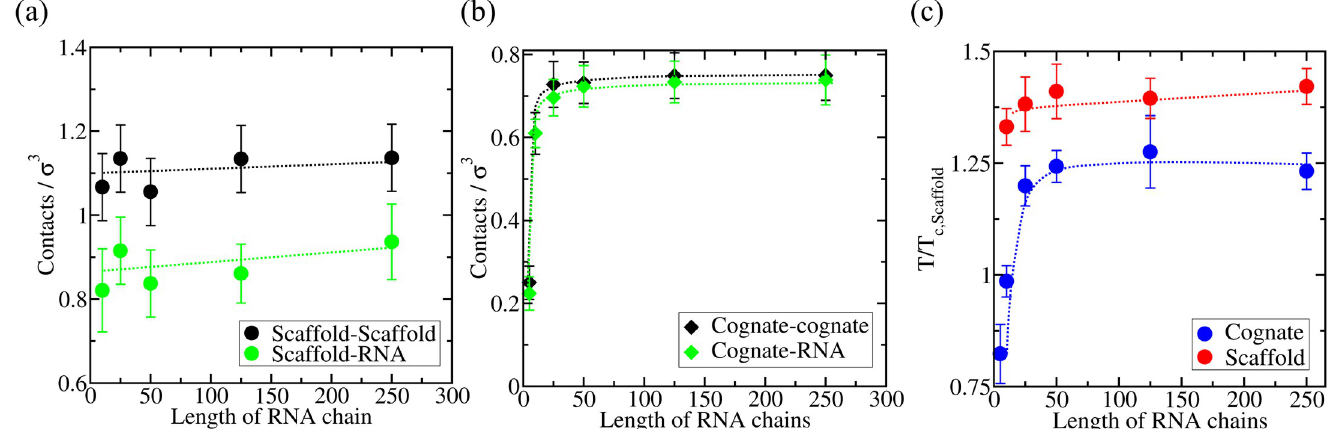
Fig 6. Density of LLPS-stabilizing contacts as a function of RNA length plotted separately for protein–protein contacts (black symbols) and protein–RNA contacts (green symbols) for a minimal RNA-binding scaffold protein model wherein scaffold proteins can phase separate via homotypic interactions (a), and an RNA-binding cognate protein model wherein cognate proteins can only phase separate via heterotypic RNA–protein interactions (b). Calculations are performed at T = T � ¼ 0 : 924 for the RNA/cognate protein system. Error bars depict the computed standard deviation in the number of 1 : 13 for the RNA/scaffold system and T = T � c ; Scaffold molecular contacts. The RNA/protein concentration was kept at a constant nucleotide/protein ratio of 0.25 in both cases. (c) Critical temperature versus RNA length plot for both mixtures, scaffold proteins + RNA (red) and cognate proteins + RNA (blue).